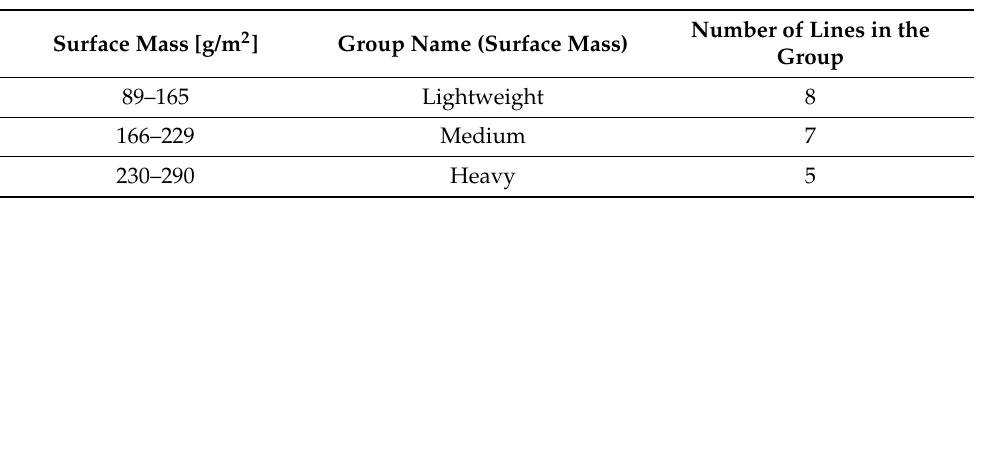
Table 4. TSL’s population, divided into groups based on their substrate surface mass .